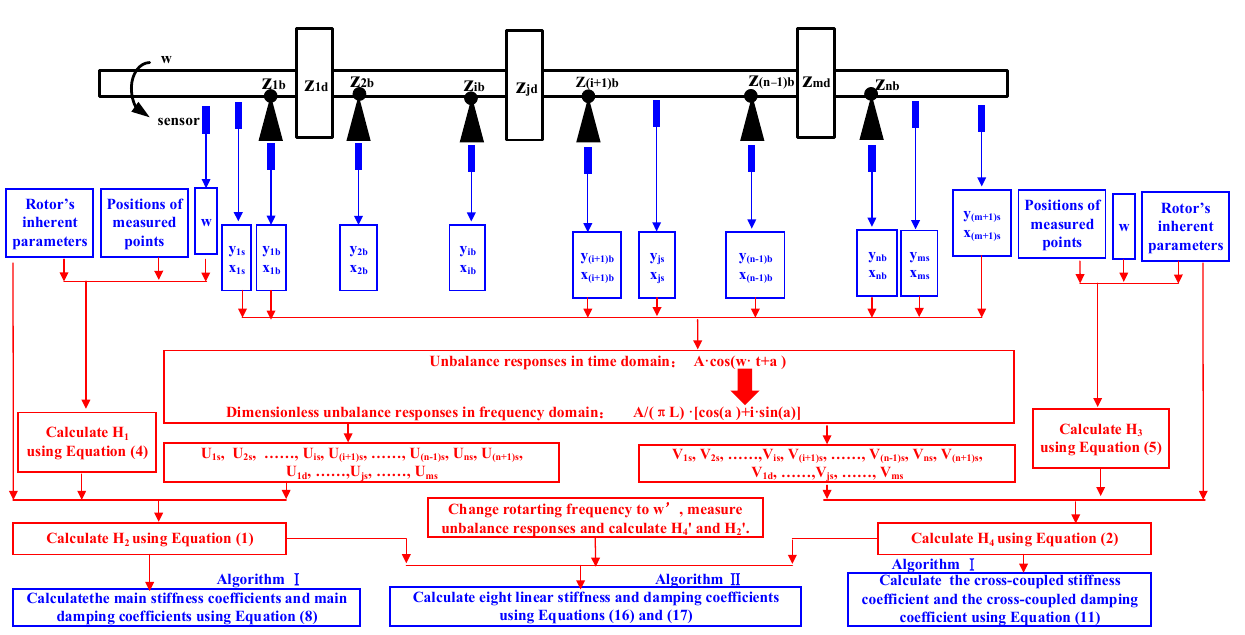
Figure 2. Identification procedures of Algorithm I and Algorithm II.